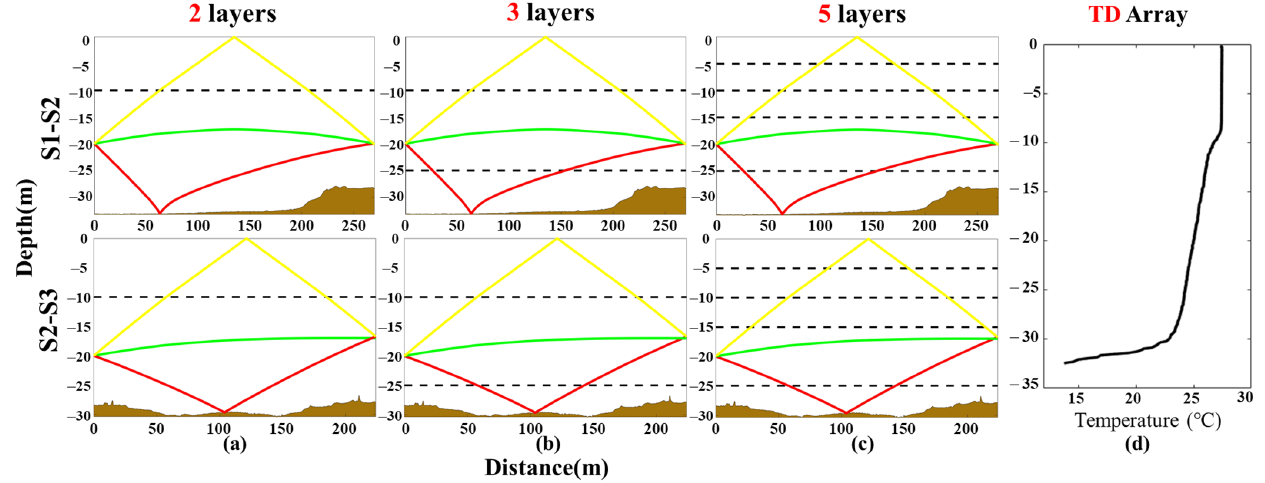
Figure 4. Ray simulations of different layer types in S1–S2 and S2–S3 . ( a ) Ray simulation of Number 2-2. ( b ) Ray simulation of Number 3-7. ( c ) Ray simulation of Number 5-2. ( d ) Temperature profiling.